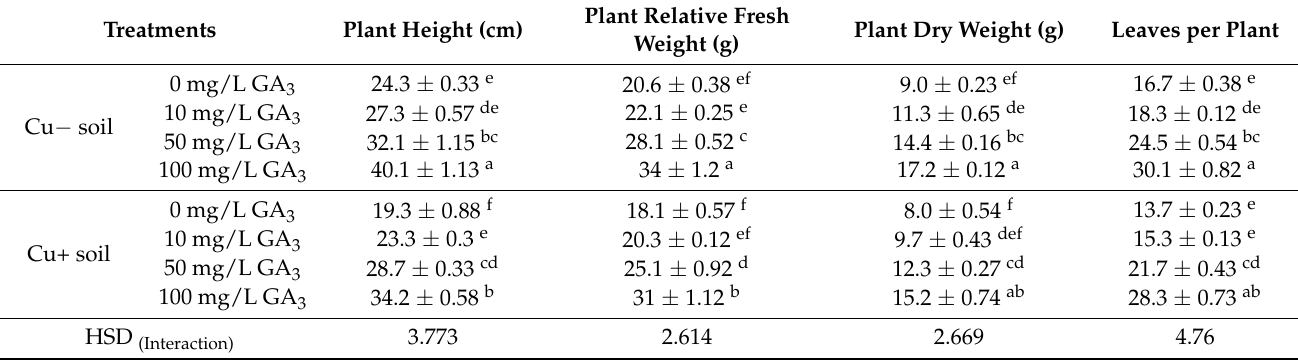
Plant Relative Fresh Plant Dry Weight (g) Leaves per Plant Weight (g)